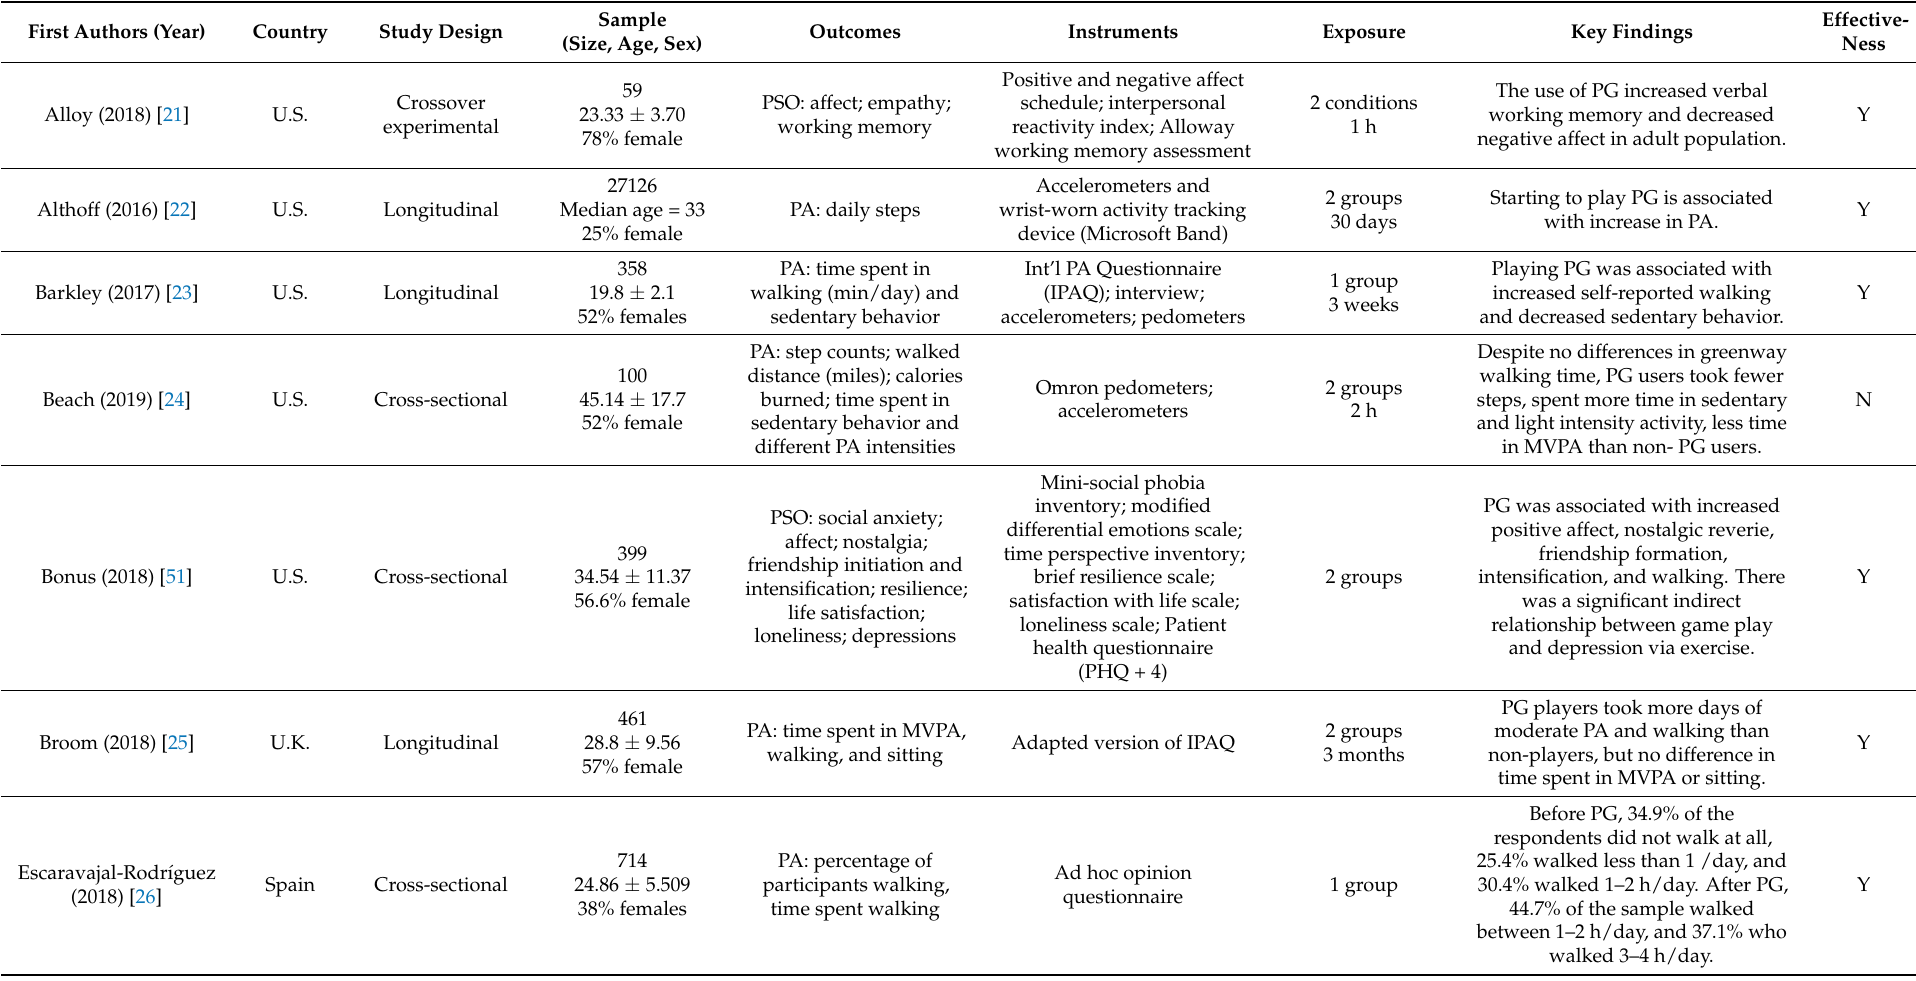
Table 1. Summary of the sample, outcome, and findings of the Pok é mon GO